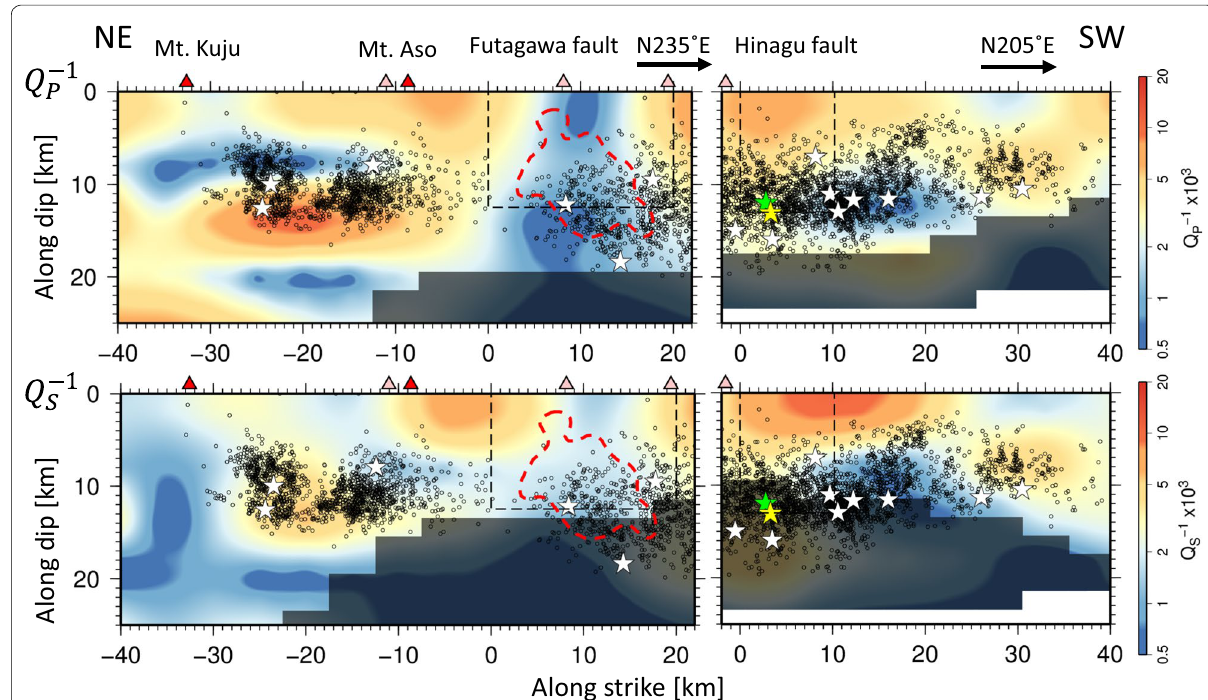
Fig. 6 Q − 1 P ( upper ) and Q − 1 S ( lower ) distribution along the planes shown in Fig. 5. Two dashed squares indicate the source fault planes estimated by Kato et al. (2016) and GSI (2016). The region enclosed by the red dashed line is the large-slip area ( Iwata (2016). See the captions of Figs. 3 and 5 for an explanation of the